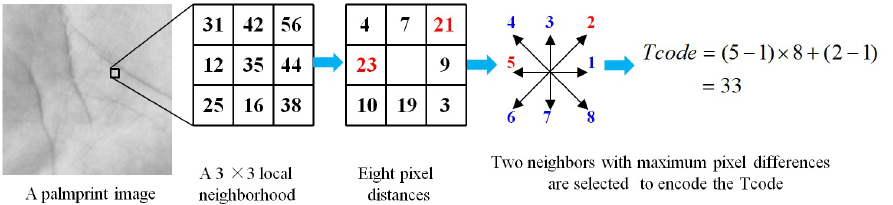
Figure 2. The basic procedure of texture feature code calculation of a palmprint image. Given a pixel of a palmprint image, we first calculate the pixel distance between the pixel and its eight neighboring points. Then, we select the two neighboring points with the two maximum pixel distances and encode the position of them into the texture feature code.